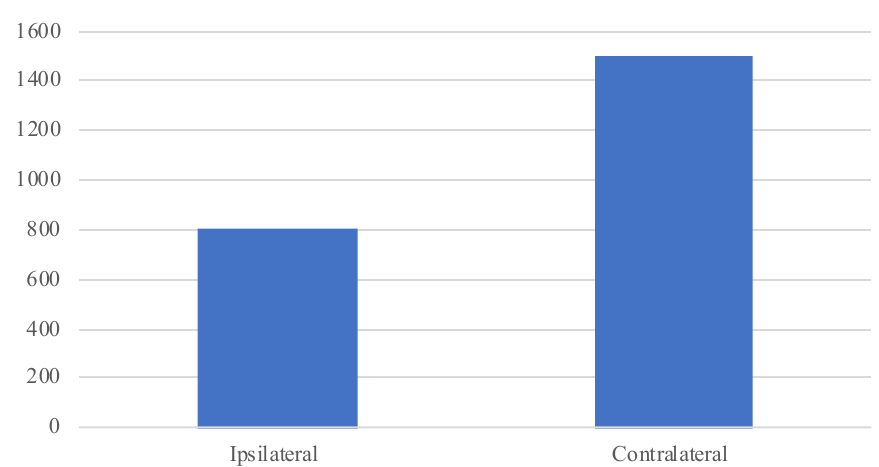
Figure 6. Graphic based on PAX7 positive cells count in 150 fibres, both for ipsilateral and contralateral muscles. Results show a lower number of satellite cells in the ipsilateral muscle if compared to the contralateral